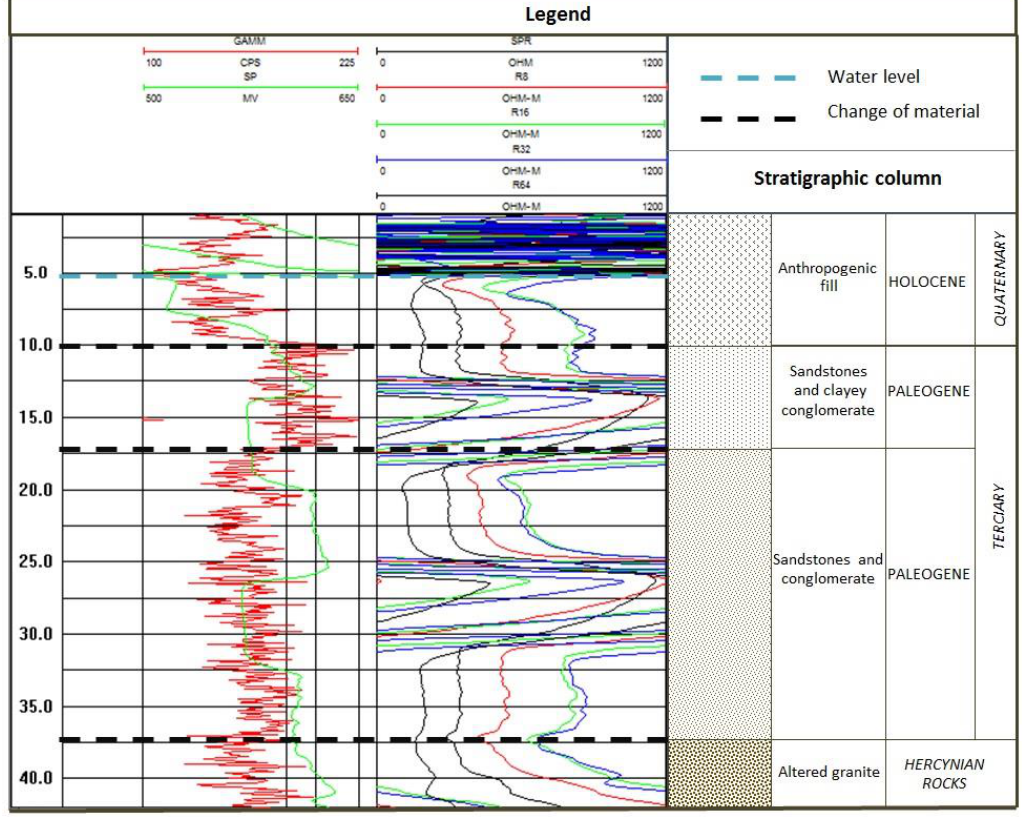
Figure 2. Well logging data and stratigraphic column of the borehole under study.